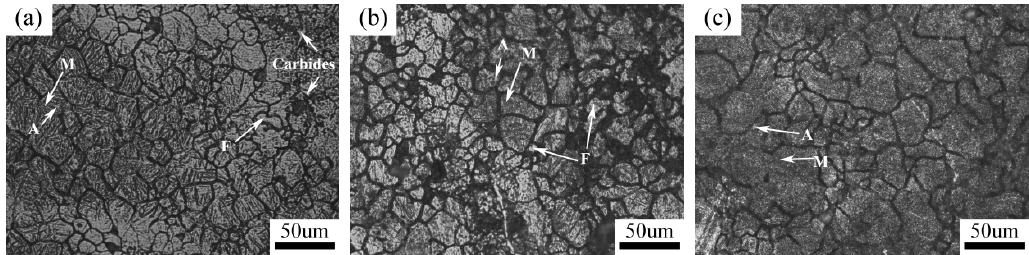
Figure 13. Microstructure of the incomplete quenching zone at different heat inputs. ( a ) 4.2 kJ/cm,